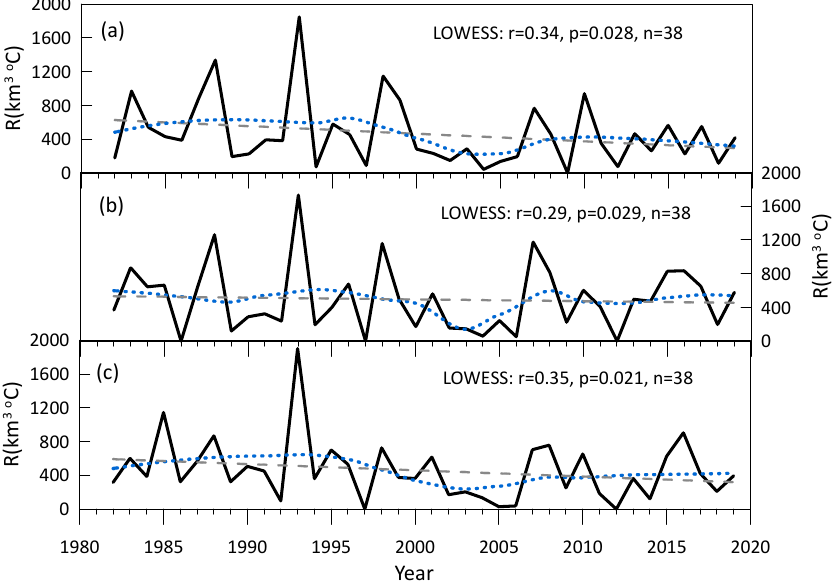
Figure 3. Temporal variation in upwelling intensity (R) from 1982 to 2019 for the Pingtan upwelling (PTU, a ), Dongshan upwelling (DSU, b ), and Taiwan Bank upwelling (TBU, c ). The blue dotted lines and grey dashed lines represent the LOWESS fit lines and linear fit lines, respectively.